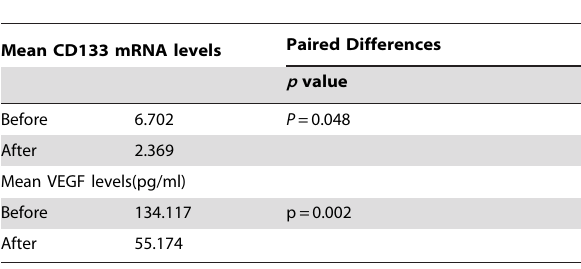
Table 2. Mean CD133 mRNA and VEGF levels before and after treatment (n